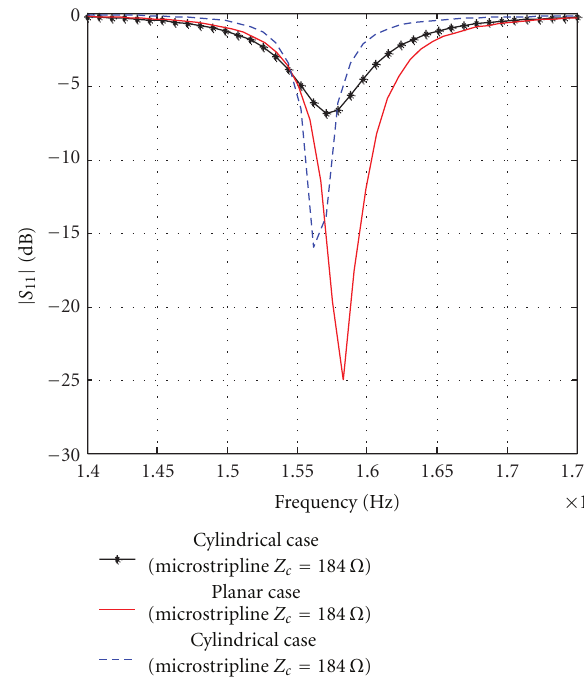
Figure 10: Comparison of the reflection coe ffi